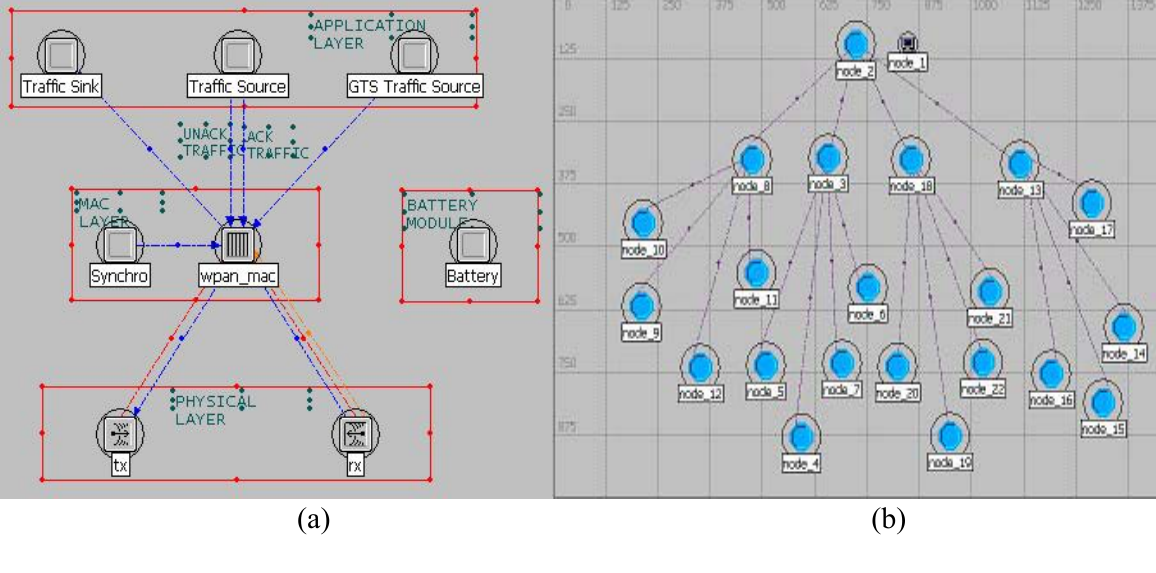
Figure 8. Data transmission sequence chart.